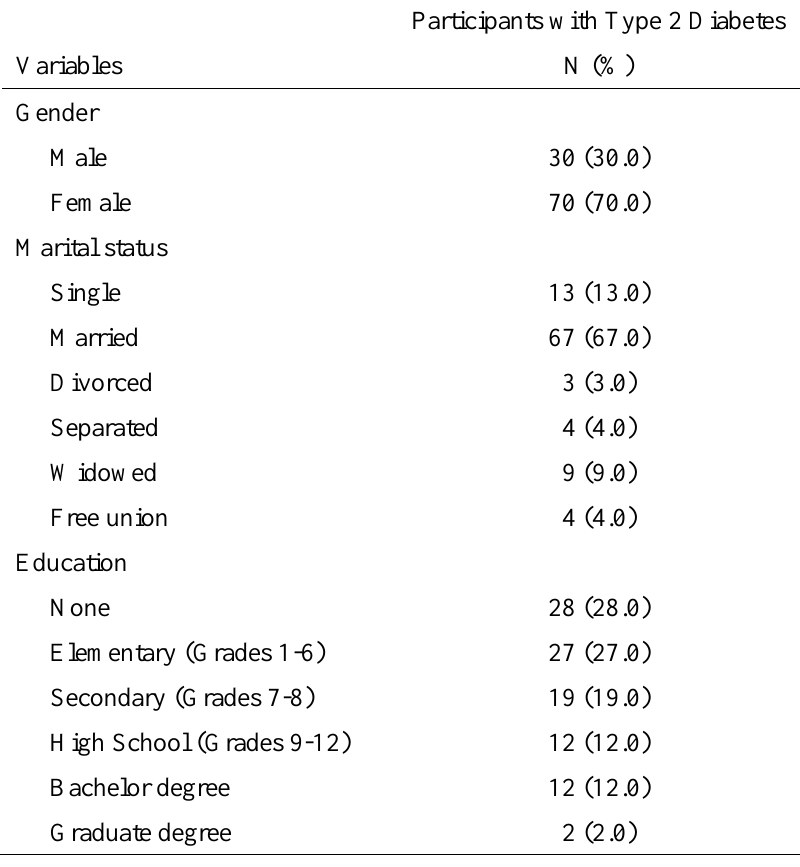
Table 1: Qualitative socio-demographic characteristics of participants with Type 2